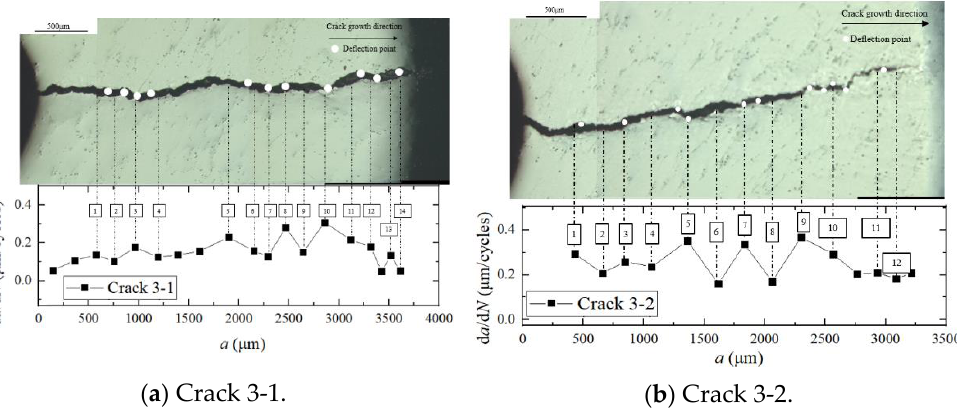
Figure 18. Relationship between crack growth path and crack growth rate.